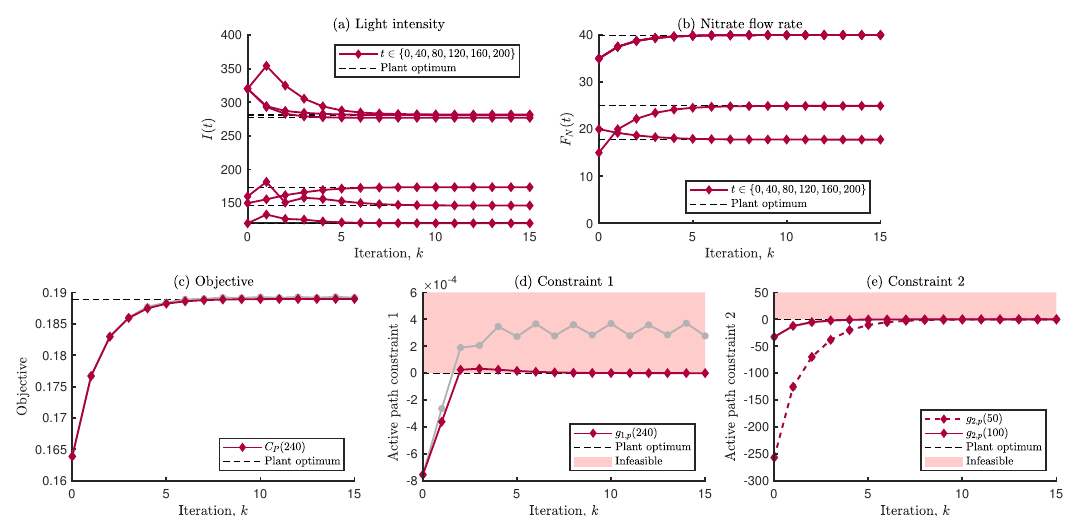
Figure 14. Multi-solution MA inputs and NLP functions using the minimum modifier solution approach shown as the red diamond line. Top row, inputs. Bottom row, objective and constraints which are active at plant optimum, where the standard MA approach is shown as the grey circle